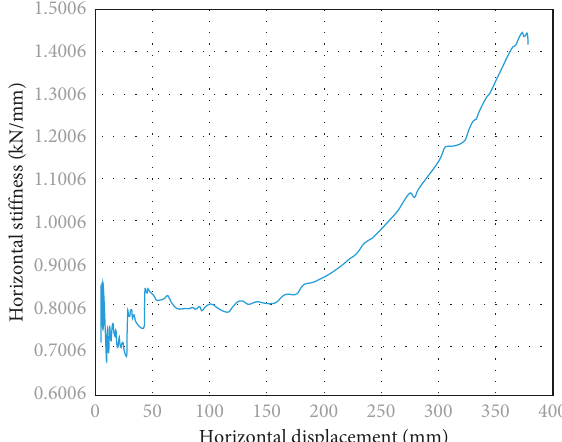
Figure 18: The relationship between horizontal stiffness and horizontal